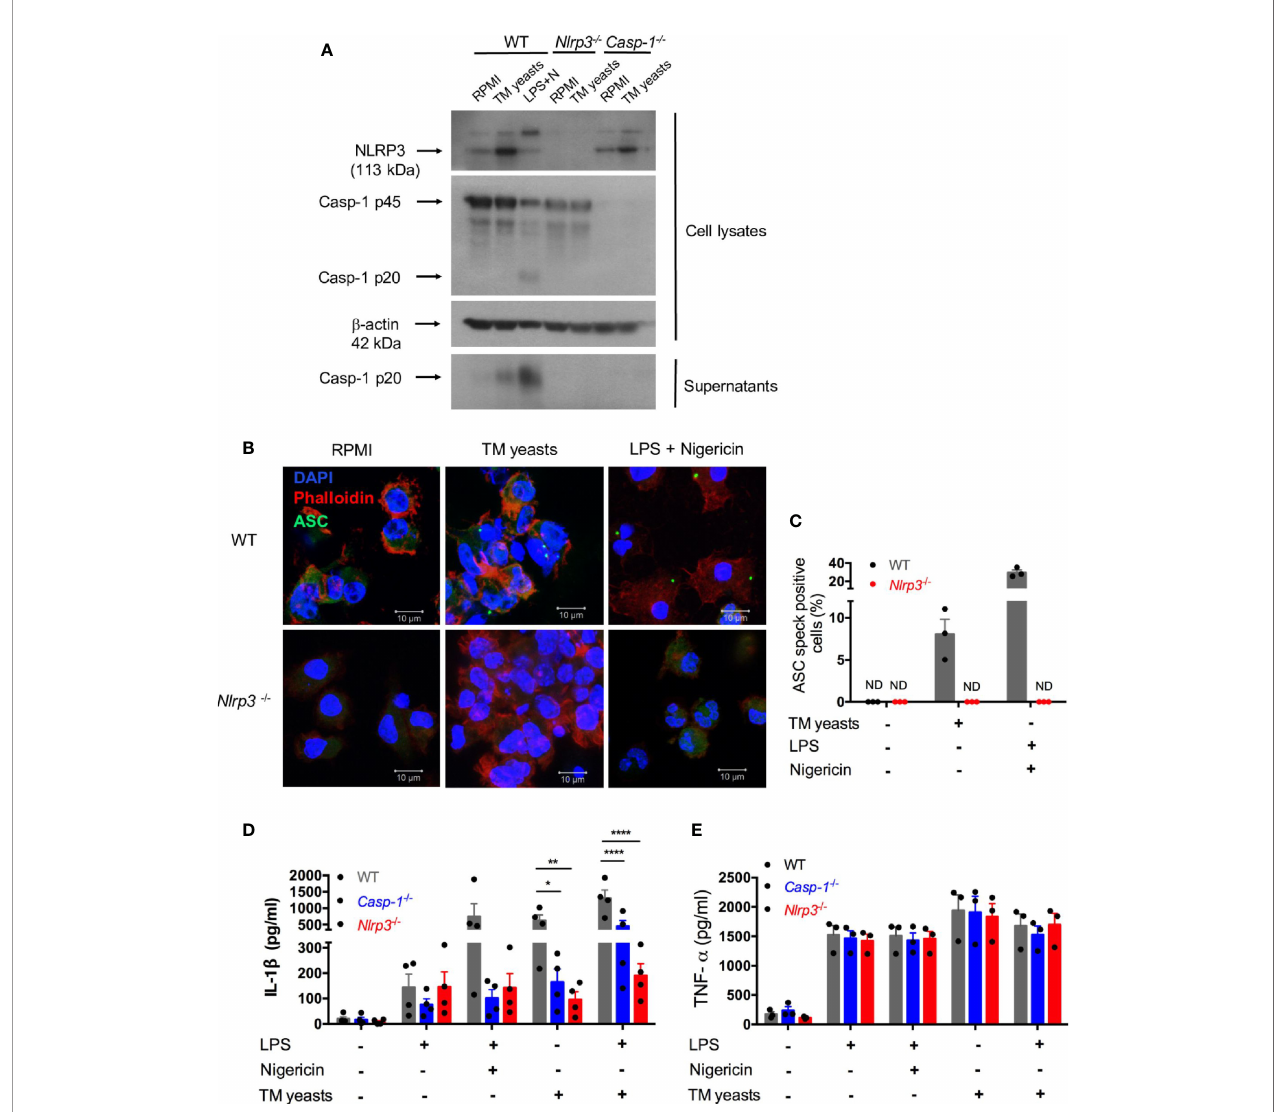
FIGURE 4 | T. marneffei yeasts trigger IL-1 b production via the NLRP3 in fl ammasome. (A) Representative immunoblots of NLRP3, caspase-1 p45 and p20 from cell lysates and caspase-1 p20 from concentrated cell supernatant in WT, Nlrp3 -/- and Casp-1 -/- murine BMDCs stimulated with heat-killed T. marneffei (TM) yeasts (1 MOI) for 18 hr, or LPS plus nigericin as a positive control (n=3). (B, C) Representative confocal micrographs and the percentages of ASC specks formation in WT, Nlrp3 -/- murine BMDCs (2x10 6 /ml) stimulated with heat-killed T. marneffei (TM) yeasts (1 MOI) for 18 hr, or LPS plus nigericin as a positive control. (D, E) Quantitative detection of IL-1 b and TNF- a by ELISA in the cell supernatant of WT, Casp-1 -/- and Nlrp3 -/- murine BMDCs (2x10 6 /ml) stimulated with heat-killed T. marneffei (TM) yeasts (1 MOI) for 18 hr with or without LPS priming, or LPS plus nigericin as a positive control. The percentages of ASC speck positive cells are quanti fi ed and depicted as mean ± SEM of n=3 mice for each group, and “ ND ” denotes “ not detectable ” (C) . Data represent mean ± SEM of n=4 mice, and data are analyzed by two-way ANOVA (D, E) . *p < 0.05, **p < 0.01, ****p <